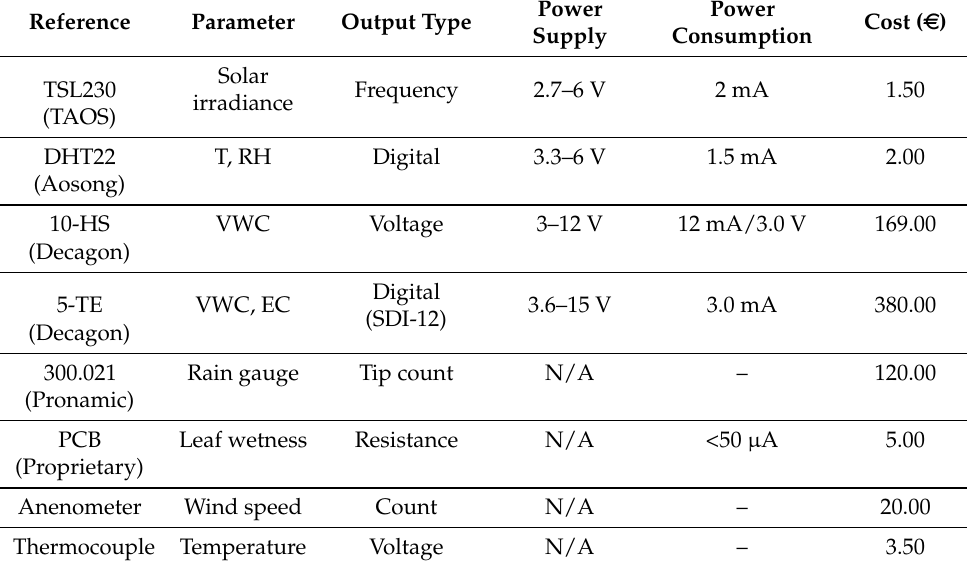
Table 2. Low-cost or/and common sensors identified as possible solutions for agrometeorology measurements in PA